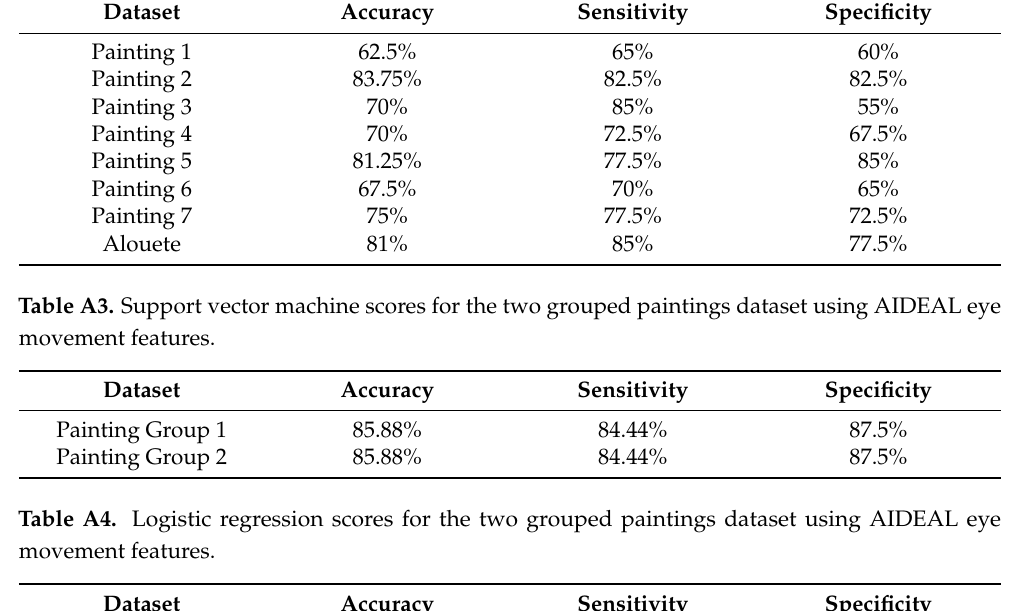
Table A2. Logistic regression scores for Aideal based data sets.